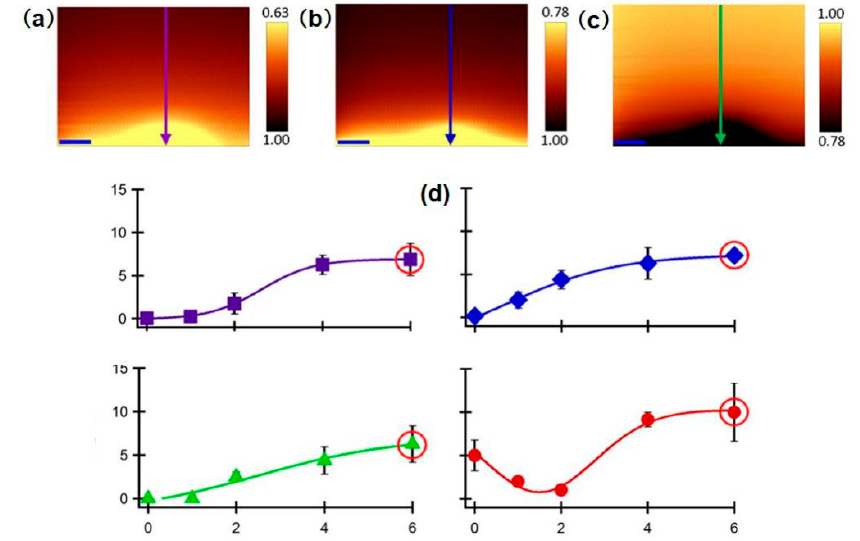
Figure 13. Typical SECM depth scan images of single T24 collected using redox mediators: ( a ) FcCOO − , ( b ) Fc(COO)2 2 − , and ( c ) Ru(NH3)6 3+ . ( d ) Average membrane permeability of T24 cells preincubated with 25 µ M of Cd 2+ as a function of incubation time using the following molecular probes: FcCOO − (purple squares), Fc(COO) 22 − (blue diamonds), Ru(NH3) 63+ (green triangles), and FcCH 2 OH (red circles). Copyright (2016) American Chemical Society.